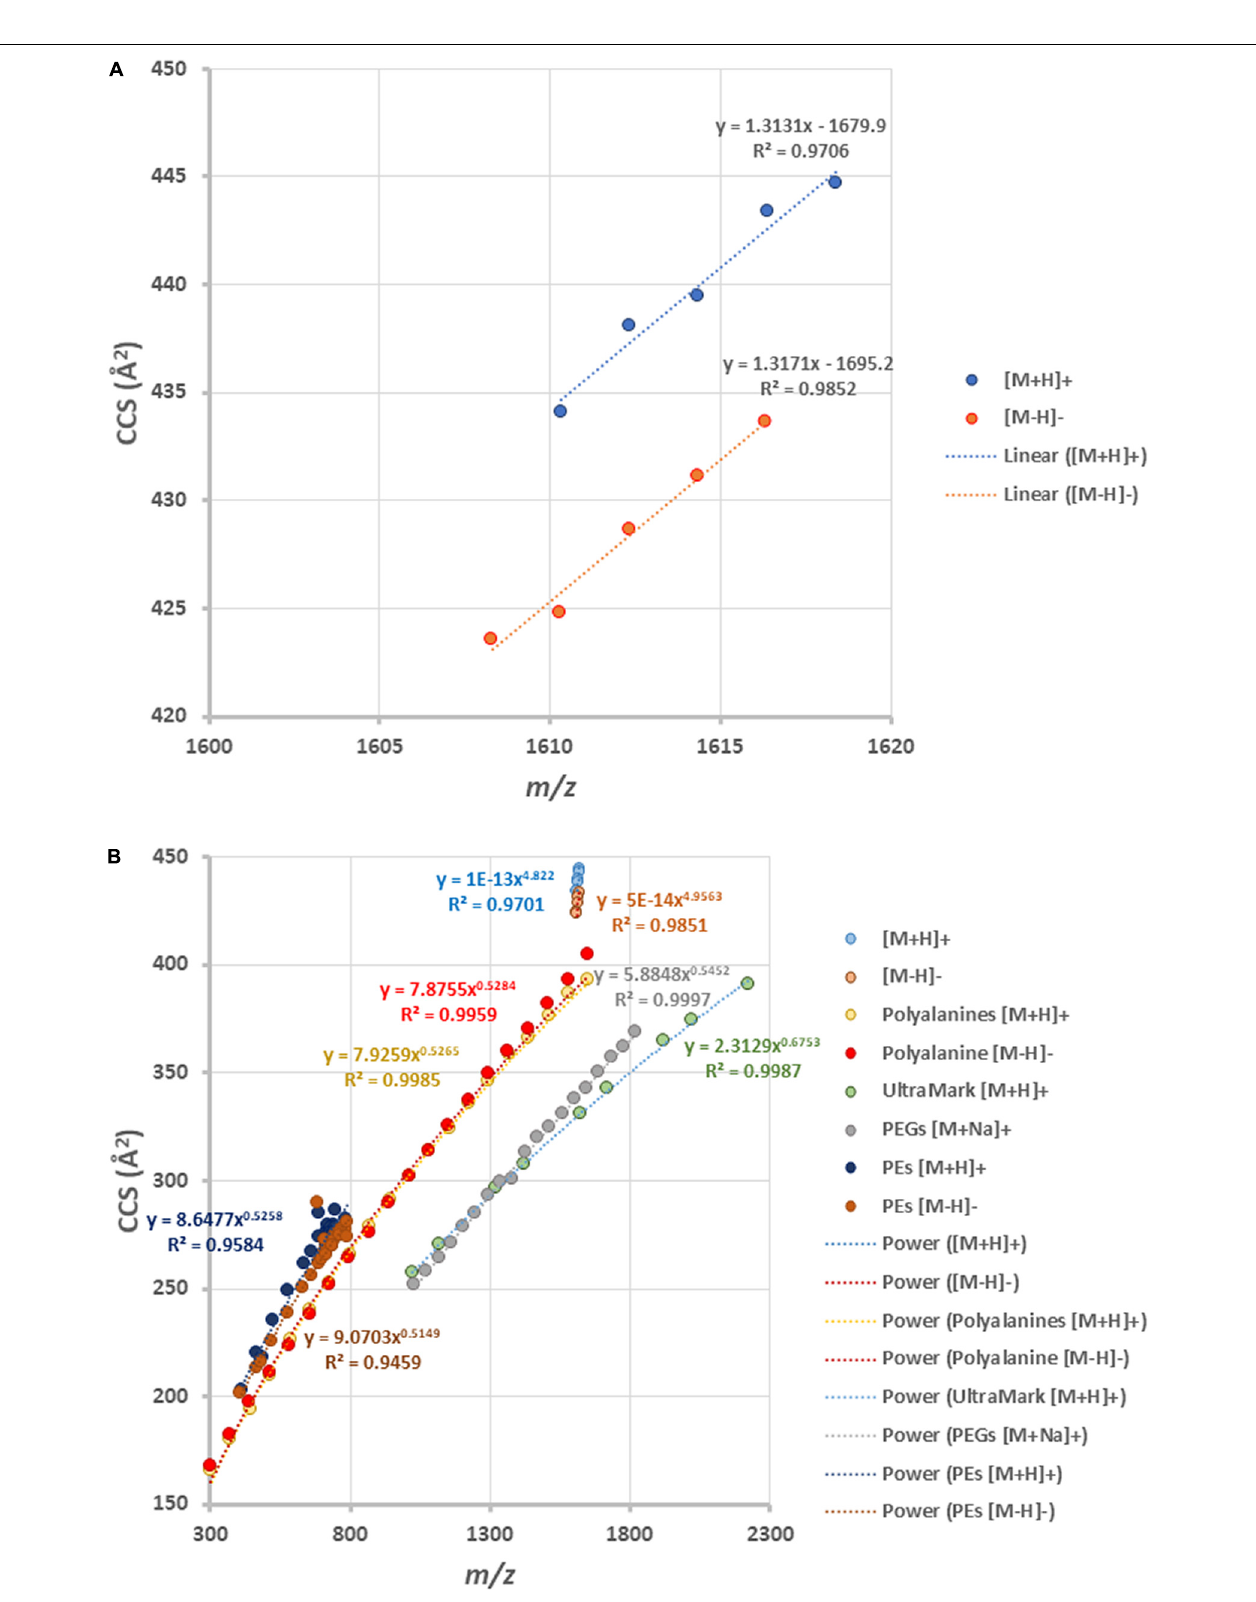
FIGURE 7 | (A) Ion mobility-mass correlation trendlines of β -L-gulopyranosyl-caldarchaetidyl-glycerols [M + H] + and [M-H] − ions. The trendlines are linear fitted. (B) Comparing the ion mobility-mass correlation trendlines of β -L-gulopyranosyl-caldarchaetidyl-glycerols with that of glycerophosphoethanolamines (PEs) [M + H] + and [M-H] − ion, polyalanines [M + H] + and [M-H] − ions, Ultramark [M + H] + ions and PEGs [M + Na] + ions. The trendlines are power fitted.